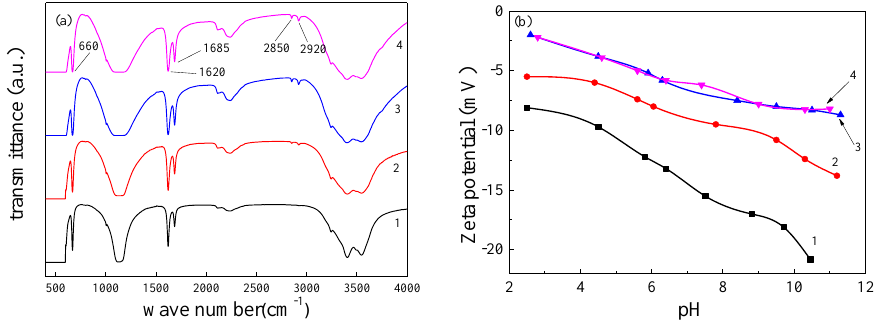
Figure 4. Variations of ( a ) Fourier transform infrared (FT-IR) spectra and ( b ) zeta potentials of α-CaSO 4 ·0.5H 2 O whiskers with the CTAB concentration (mol·L −1 ): 1—0, 2—1.0 × 10 −4 , 3—9.2 × 10 −4 , 4—1.5 × 10 −3 .